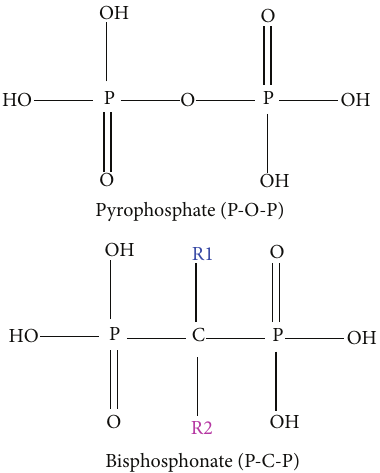
Figure 1: The molecular structure of the bisphosphonates (P-C-P) and pyrophosphates